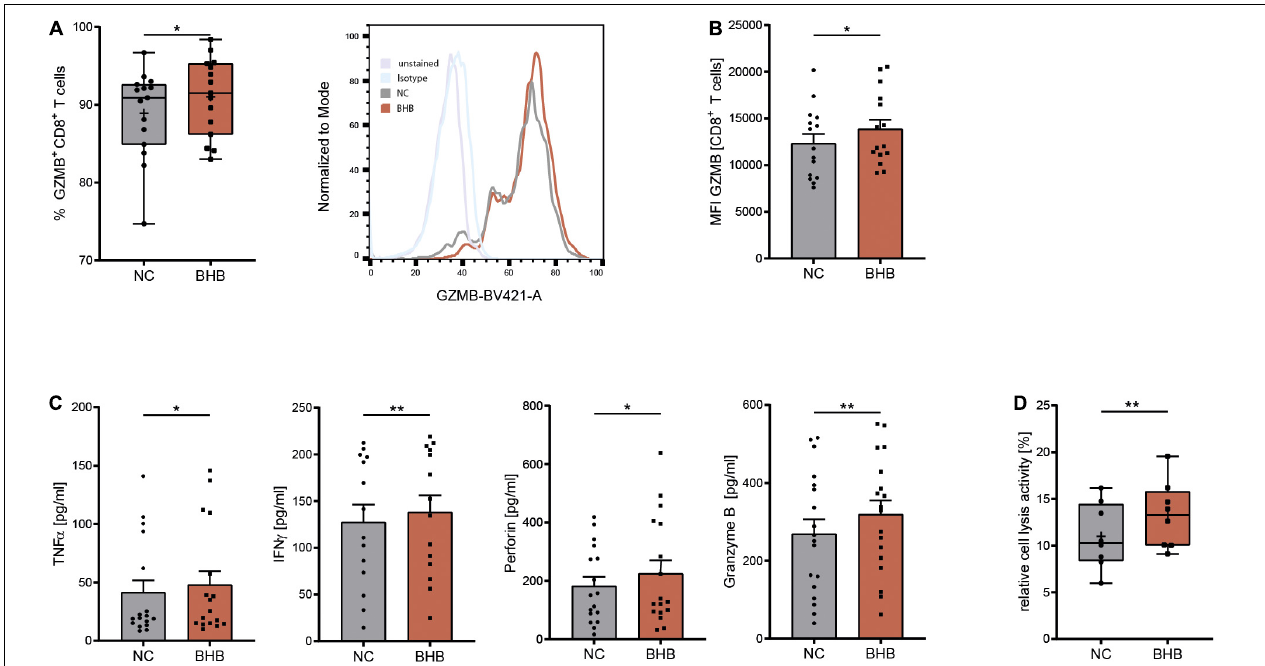
FIGURE 1 | Beta-hydroxybutyrate enhances human T-cell immune capacity during COVID-19. Human peripheral blood mononuclear cells (PBMC) were cultivated for 5 days in RPMI containing 80 mg/dl glucose (NC) and supplemented with 10 mM D/L-beta-hydroxybutyrate (BHB). T-cell stimulation was performed through CD3/CD28 Dynabeads at a bead:cell ratio of 1:8. (A) Flow cytometric quantification of CD8 + T cells expressing intracellular Granzyme B (left), n = 15 individual patients. For better visualization, a histogram example of one patient is shown. (B) Mean fluorescence intensity (MFI) Granzyme B per cell, measured in CD8 + T cells (right), n = 15 individual patients. (C) Protein expression of TNF α /IFN γ /Perforin/Granzyme B in the supernatant of stimulated PBMC, n = 17/14/17/18 individual patients. (D) Relative CD8 + cell lysis activity as measured by calcein-fluorescence of isolated CD8 + T cells, n = 8 individual patients. Paired t -test or Wilcoxon matched-pairs signed rank test, as appropriate. * p < 0.05, ** p < 0.01.